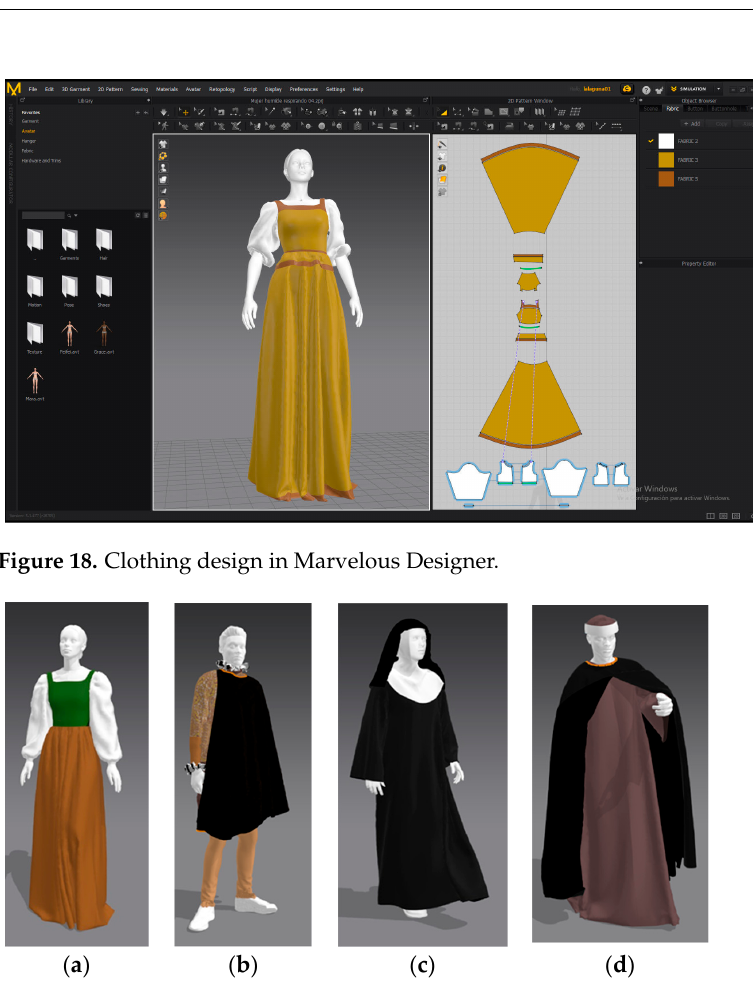
Figure 19. 3D models for ( a ) peasant, ( b ) noble, ( c ) nun, and ( d ) doctor.